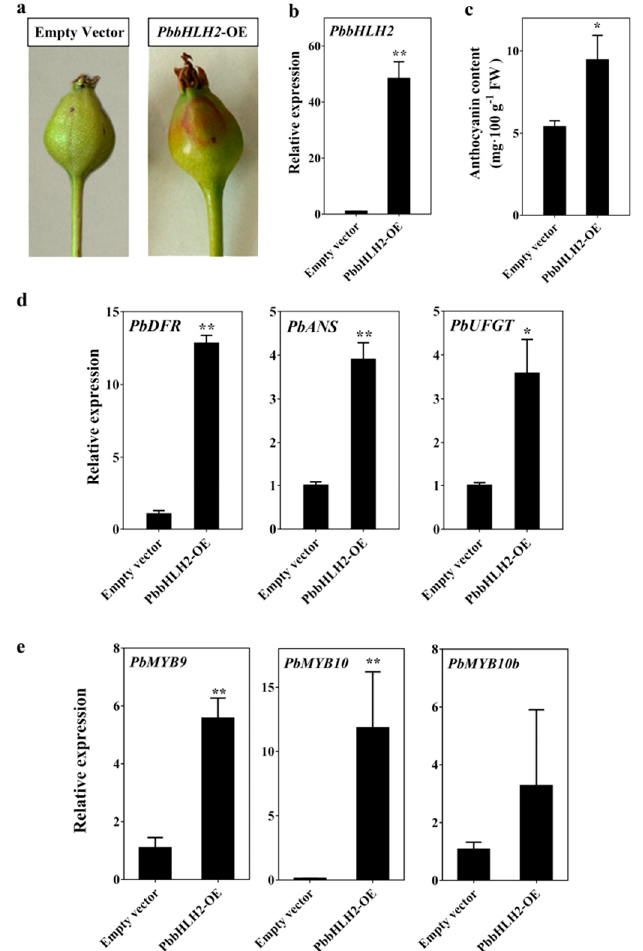
Figure 3. Anthocyanin patterns in pear fruitlets peel transiently overexpressing PbbHLH2 (PbbHLH2 -OE). ( a ) Overexpression assay of PbbHLH2 in “Zaosu” fruitlets peel; ( b ) The PbbHLH2 gene expression levels in PbbHLH2 -OE fruitlets peel; ( c ) The anthocyanin contents in PbbHLH2 -OE fruitlets peel; ( d , e ) The expression levels of PbDFR , PbANS and PbUFGT ( d ) and of PbMYB9 , 10 , and 10b genes ( e ) in PbbHLH2 -OE fruitlets peel. The significance levels of difference were determined by t -test (* = p < 0.05; ** = p < 0.01). All the data are from three biological replicates and are expressed as means ± SEs ( n = 3). All the tests were computed using SPSS (ver.20.0). 2.4. PbbHLH2 Gene was an Essential Part of the Anthocyanin Biosynthesis Pathway in the Pear Peel